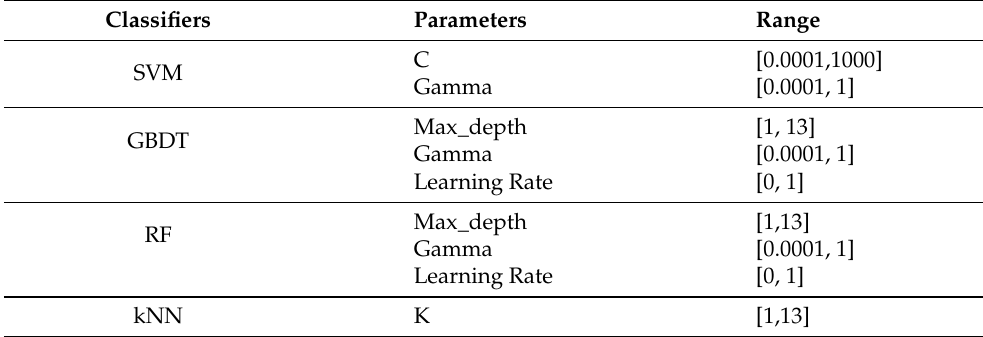
Table 2. The parameters of each classifier optimized using the MPA